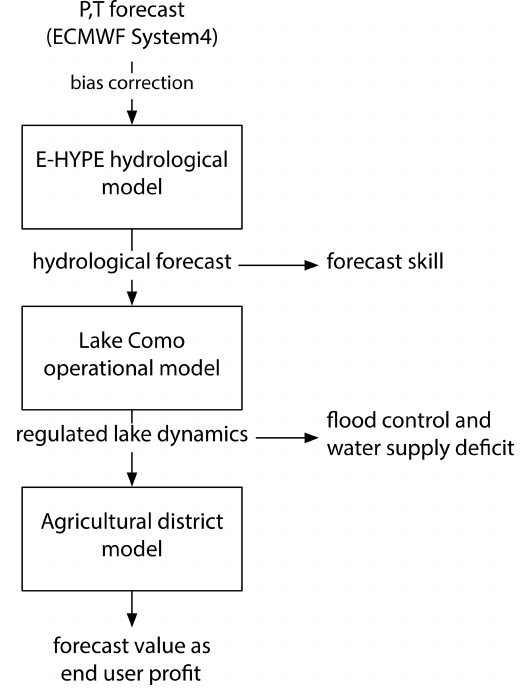
Figure 2. Overview of the integrated modeling chain used in the evaluation